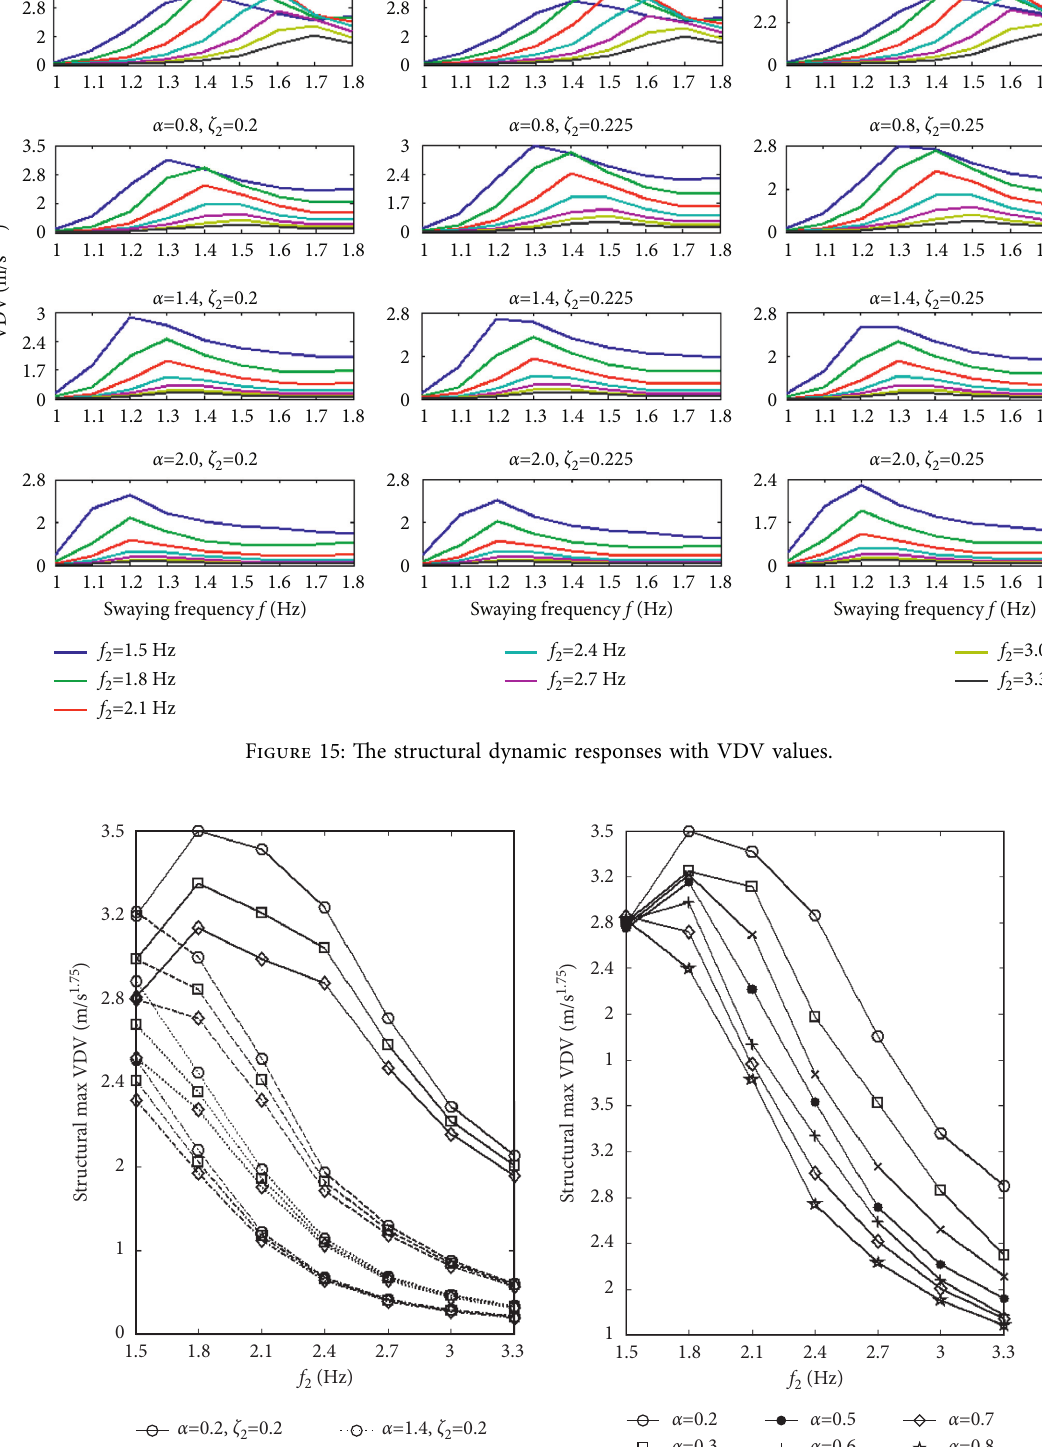
2 α ζ 2 ; (b) the max VDV when